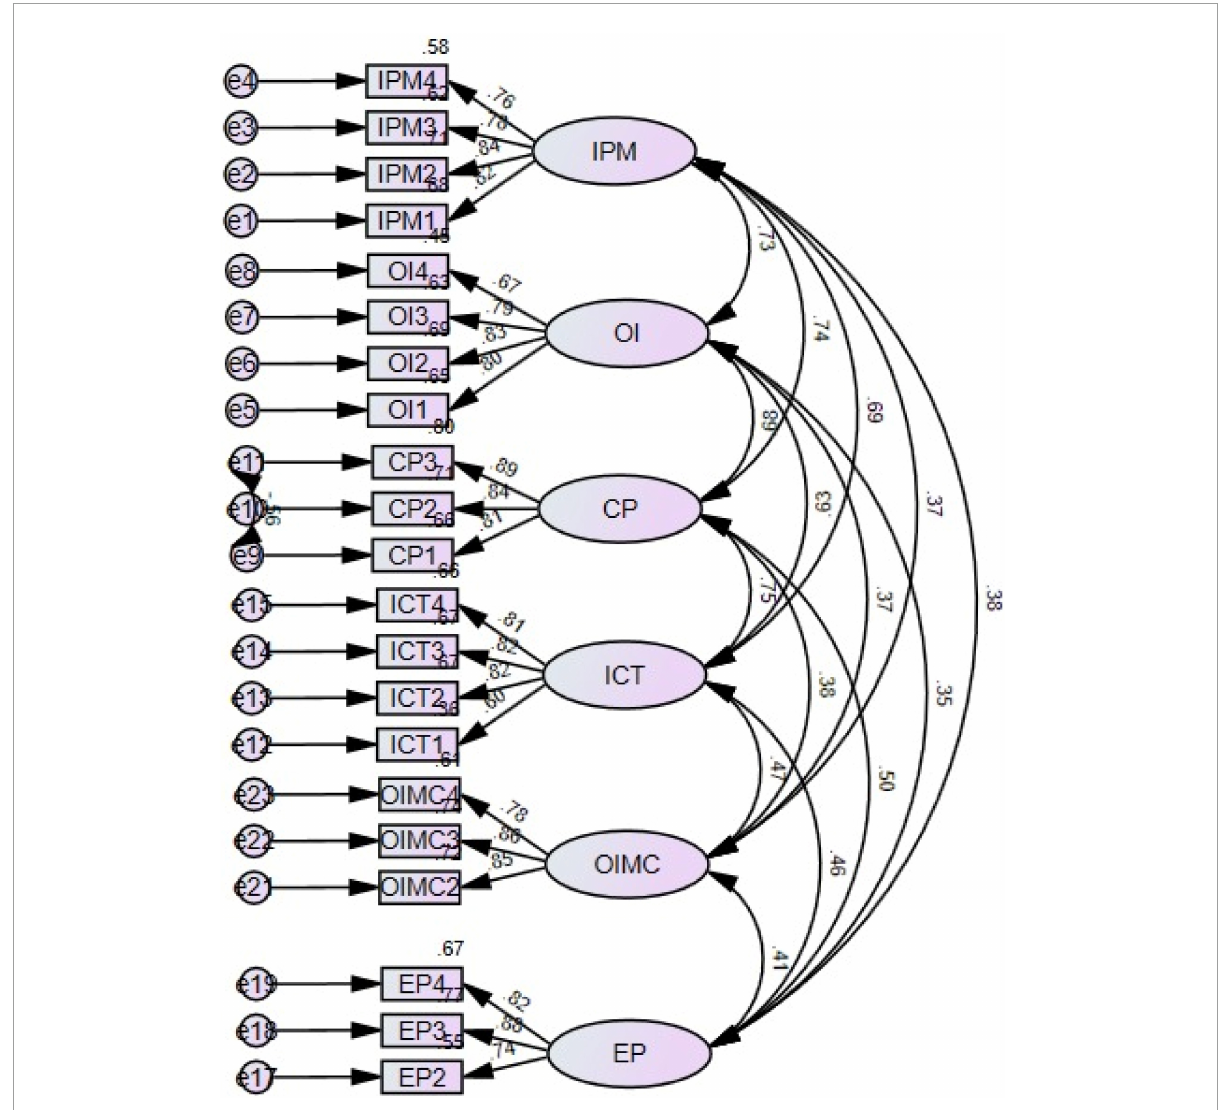
FIGURE2 Measurement model. IPM, Intellectual Property Management; OI, Open Innovation; CP, Commercialization Performance; ICT, Information Communication Technology; EP, Entrepreneurial Performance; OIMC, Open Innovation Model